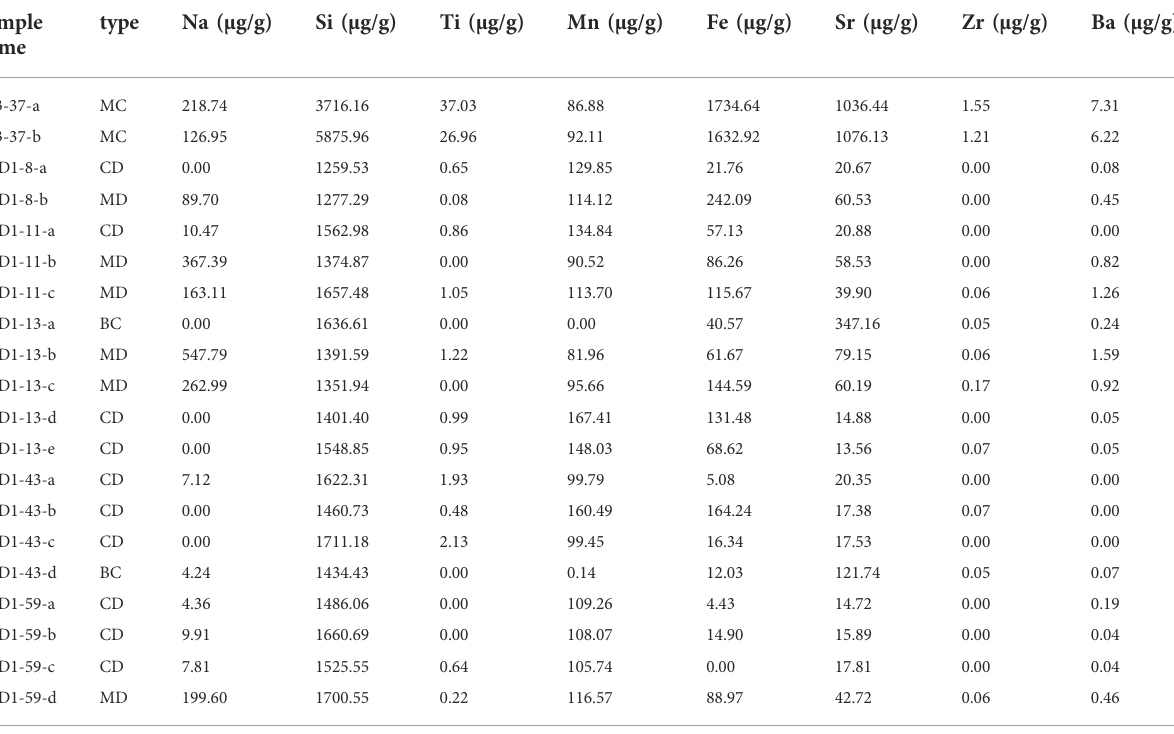
TABLE 1 Major and minor elements results of the Xiaoerbulake Formation